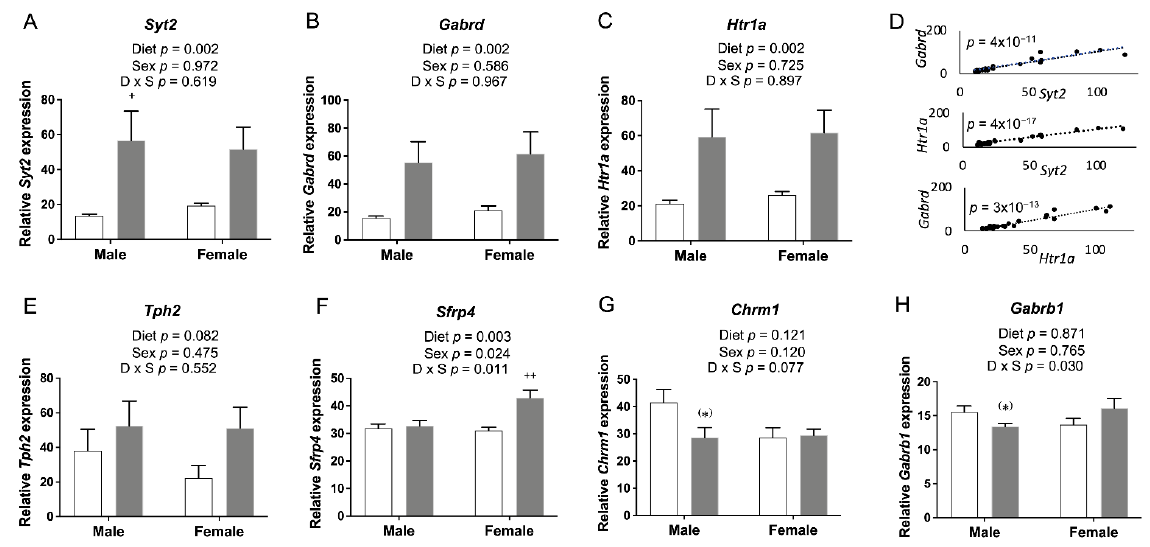
Figure 9. qRT-PCR of genes involved in neurotransmission and neuronal growth and development in embryonic cerebrum. mRNA levels of ( A ) Syt2 , ( B ) Htr1a , and ( C ) Gabrd were significantly increased by FASD. ( D ) Expression of Syt2 , Gabrd , and Htr1a showed positive correlations with each other: Syt2 and Gabrd : r = 0.929, p = 4 × 10 −11 ; Syt2 and Htr1a : r = 0.976, p = 4 × 10 −17 ; Htr1a and Gabrd : r = 0.946, p = 3 × 10 −13 . ( E ) mRNA levels of Tph2 showed a trend toward a significant increase in the FASD group. ( F ) mRNA levels of Sfrp4 were significantly increased in the FASD group, especially in FASD females compared with CD females. mRNA levels of ( G ) Chrm1 and ( H ) Gabrb1 showed a trend toward significant decreases in FASD males compared with CD males. Values are means ± SEM of 5–6 per group. White bars: CD groups; gray bars: FASD groups. p -Values from 2-factor ANOVA are indicated in each graph. Tukey post hoc p -values are indicated as + p < 0.05, ++ p < 0.01, and unpaired t -test p -values are indicated as ( * ) p = 0.059. CD, control diet; FASD, folic-acid-supplemented diet; D: diet; S: sex; D × S: diet × sex interaction.